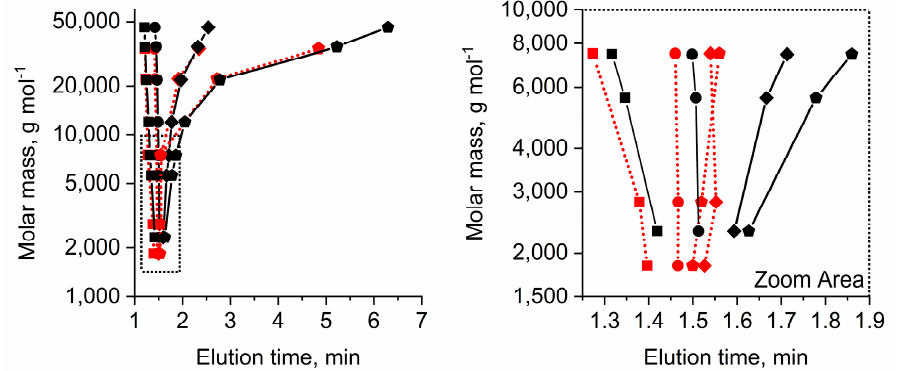
Figure 2. Molar mass ( M n ) elution time plot of PEGdiol (red symbols and red dotted connecting lines) and mPEG (black symbols and black connecting lines) indicating the transition between the size exclusion mode toward the adsorption/partition mode reached first for the larger molar masses. Symbols indicating percentage acetonitrile/water (%, v / v ): 50/50 (squares), 42/58 (circles), 41/59 (diamonds), and 40/60 (pentagons). The zoom area clearly shows that the smaller mPEGs elute significantly later than diols at a mobile phase composition of 40/60 (pentagons). Mobile phase flow rate of 1 mL min − 1 .